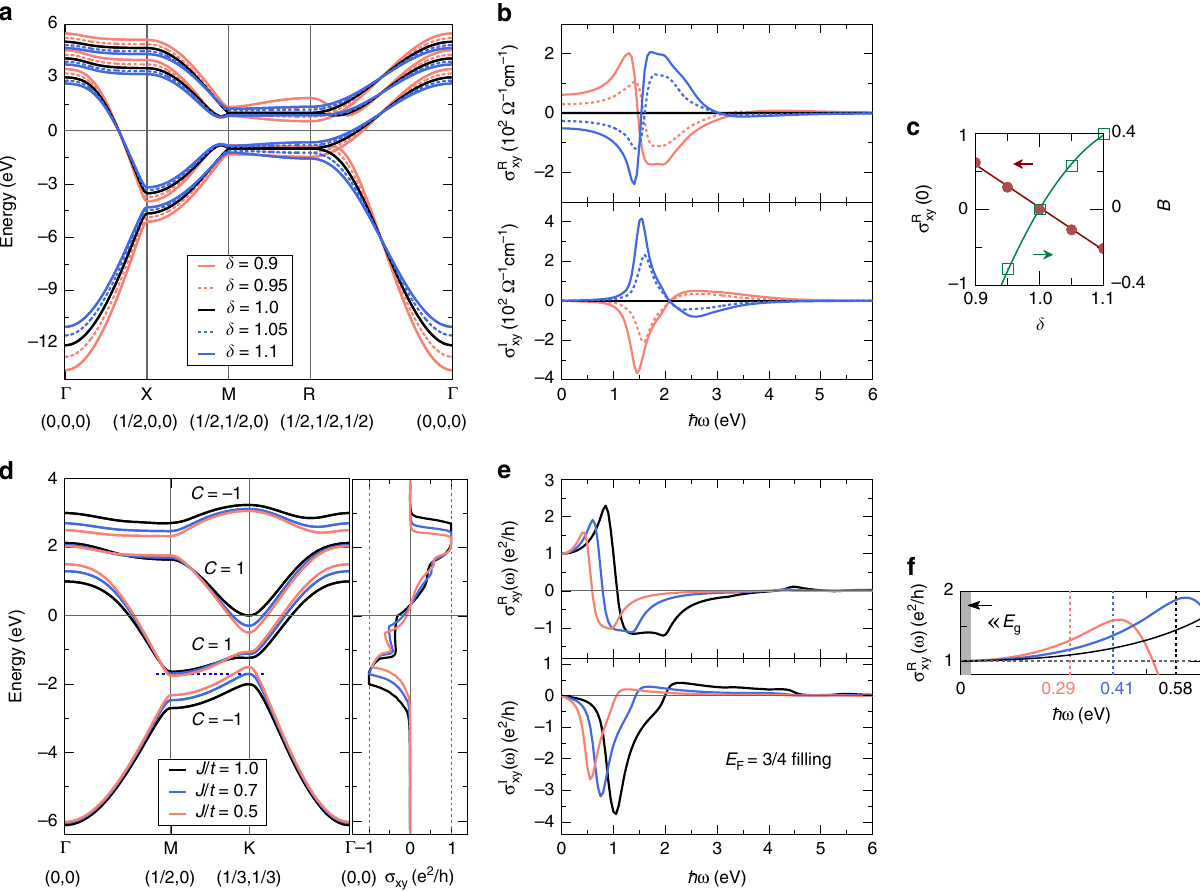
Fig. 2 Electronic structure and magneto-optical conductivity of 3 Q noncoplanar antiferromagnets. a Band structure of the 3D fcc lattice ( J = t ¼ 1 : 0). b Magneto-optical conductivity of the 3D fcc lattice ( η ¼ 0 : 1 t ). Up and down panels show the real and imaginary parts with different δ , respectively. c Both σ R ω Þ (taking ω ¼ 0 as an example) and B are proportional to δ , verifying that σ xy ð triangular lattice. e Magneto-optical conductivity of the 2D triangular lattice ( η ¼ 0 : 1 t ). The Fermi energy corresponds to the 3/4 band fi lling. f The enlarged low-frequency region of σ R xy . The dashed vertical lines mark the band gaps at 3/4 fi lling ( E ( _ ω (cid:7) E ) in which the quantum topological magneto-optical effects g